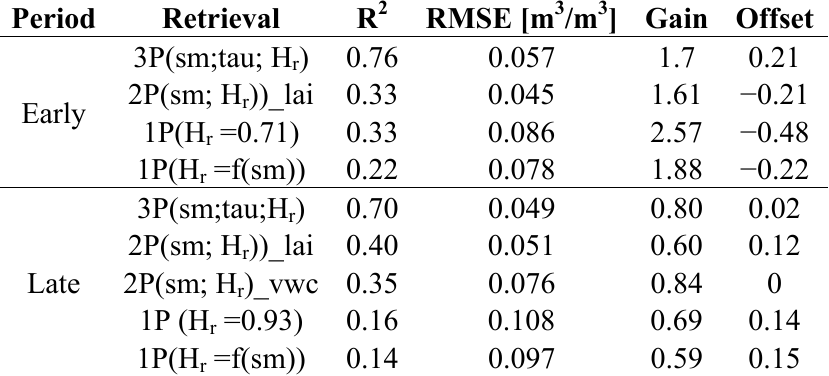
Table 5. Results from different soil moisture retrievals for the early and late growing period. During the 3P-retrieval soil moisture, tau and H and H are free in both 2P-retrievals while for one tau is calculated from LAI (2P(sm; r H )_lai) and for the other tau is calculated from VWC (2P(sm; H r 1P-retrievals with soil moisture as free parameter have been carried out. One with a constant H value (1P(H = 0.xx)) and one with H r r moisture (1P(H = f(sm))). r